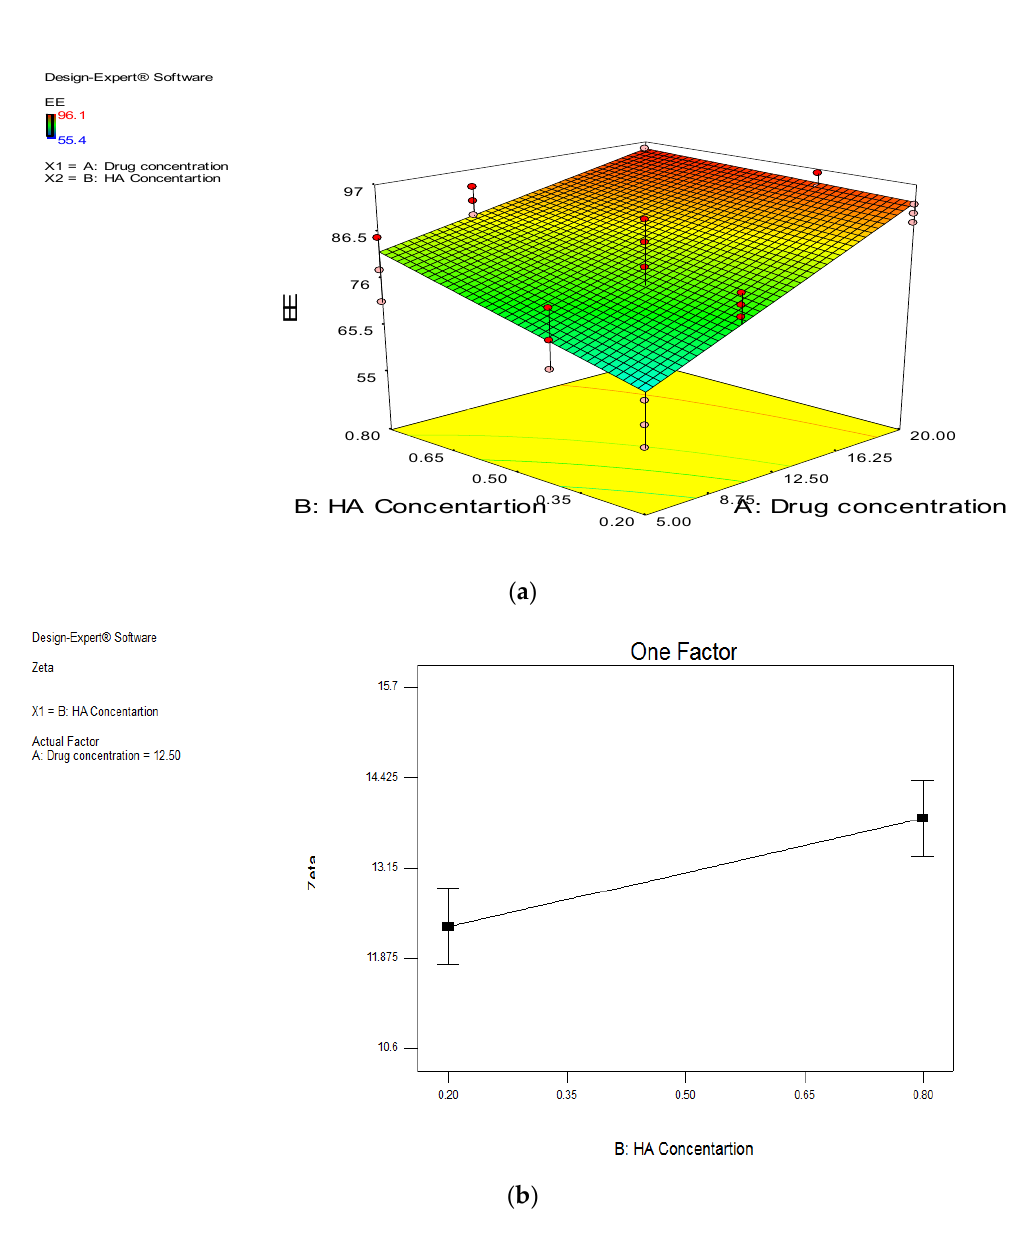
Figure 1. Chart showing: ( a ) Effect of Drug concentration on EE% and effect of HA concentration on the EE%; ( b ) Effect of HA concentration on ZP.